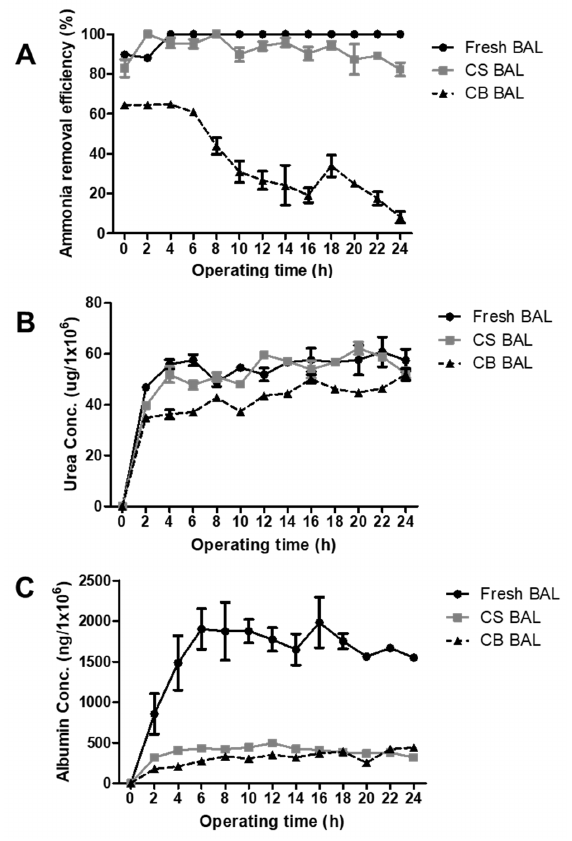
Figure 8. The functions of ammonia clearance, urea synthesis, and albumin synthesis in the bioartificial liver (BAL) system during 24 h operation. ( A ) The ammonia removal efficiency of the CS-BAL was lower than or similar to the fresh BAL system ( p > 0.05). ( B ) The urea concentrations in the media of the three BAL systems were not significantly different ( p > 0.05), and ( C ) the albumin con ‐ centration in the medium of fresh spheroid bead BAL was higher than that of the cryopreserved BAL (CS BAL, CB BAL) ( p < 0.05). During 24 h BAL operation, the mean ammonia removal efficiencies (Figure 8A) were 98.3 ± 4.1 (fresh BAL), 92.1 ± 5.7 (CS ‐ BAL), and 37.2 ± 20.2 % (CB ‐ BAL), and their mean urea concentrations (Figure 8B) were 60.0 ± 15.8 (fresh BAL), 49.2 ± 16.0 (CS ‐ BAL), and 40.0 ± 13.1 % (CB ‐ BAL). The mean albumin concentrations (Figure 8C) were 1533 ± 541 (fresh BAL), 368 ± 120 (CS ‐ BAL), and 294 ± 118 % (CB ‐ BAL). 4. Discussion The aim of this study was to develop a freezing/thawing protocol that allows the delivery of hepatocyte spheroids or immobilized hepatocyte spheroids with high func ‐ tional recovery when required for the BAL treatment of acute liver failure. While a large number of studies have described the cryopreservation of single cells, including